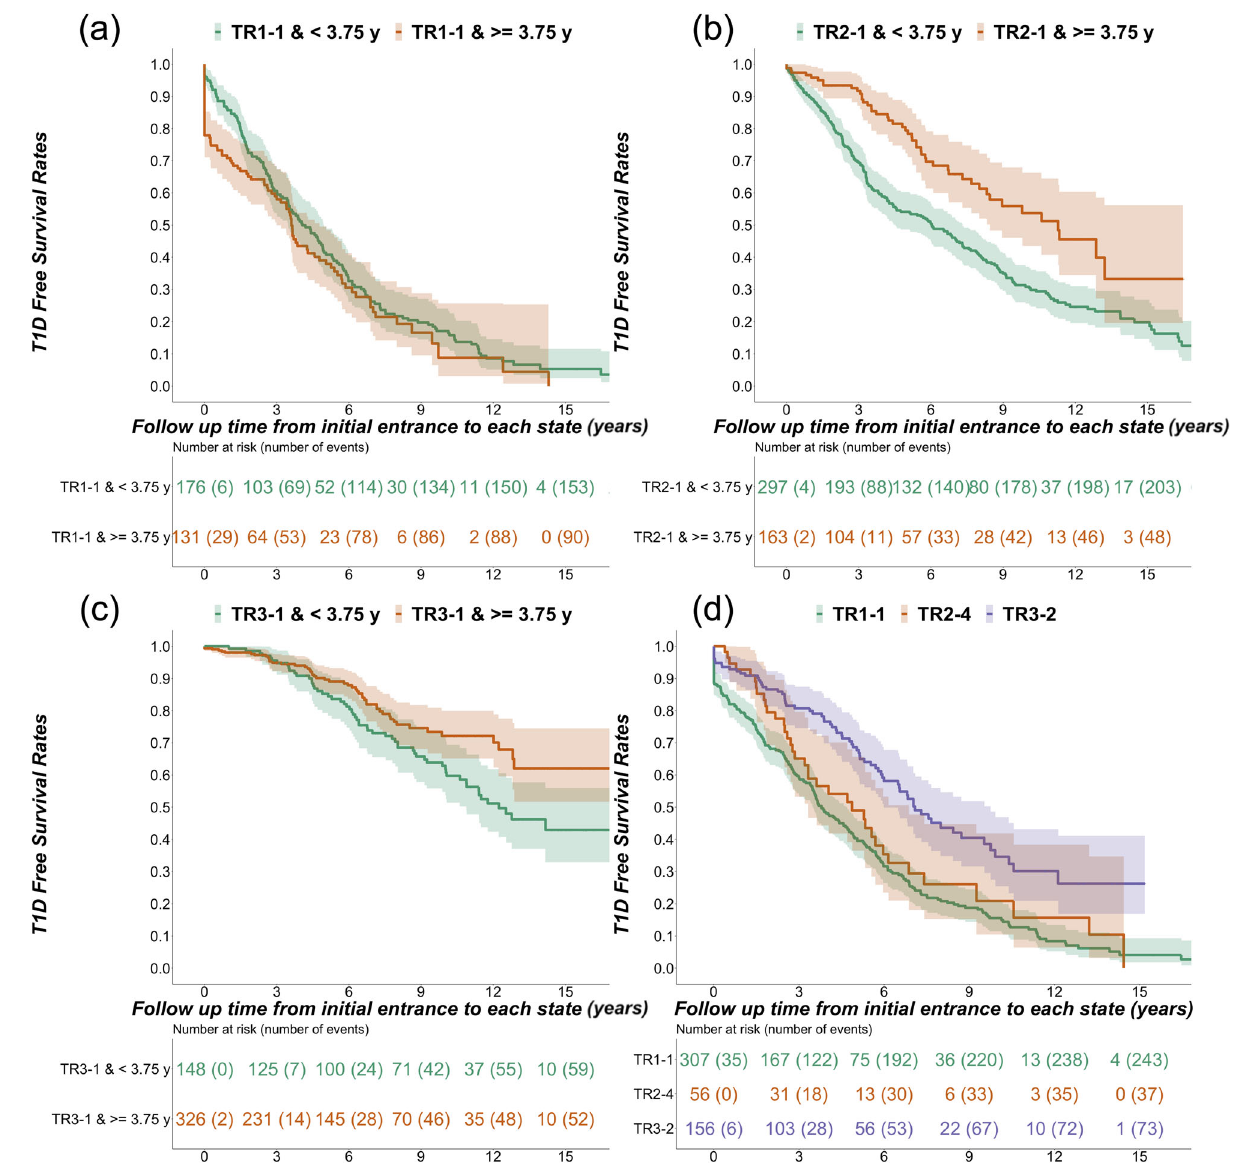
Fig. 5 Diabetes-free survival strati fi ed by age and trajectory state. T1D-free survival curves (mean and 95% con fi dence interval) of participants before or after median age, 3.75 years old, of entry into fi rst IAb positive state ( a TR1-1, b TR2-1, and c TR3-1). d T1D-free survival curves for individuals in GADA and IA-2 positive states (TR1-1, green; TR2-4, orange; TR3-2, purple). The median ages of entrance for GADA and IA-2A positive states were (i) TR1-1: 3.0; (ii) TR2-4: 7.6; (iii) TR3-2: 7.1 years old. Source data are provided as a Source Data fi age 25 years based on high-risk HLA genotype or history of fi rst-degree relative with type 1 diabetes. Presence or absence of three islet autoantibodies, GADA, IAA, and IA-2A, were combined across studies, and data were included up to a follow up (DPM) on presence or absence of IAb and the age of participants. The DPMs of 15 years or until the diagnosis of type 1 diabetes, whichever came fi rst, per discovered latent states from longitudinal measurements of the three IAbs from originating study protocols. Type 1 diabetes was diagnosed according to American each participant ’ s visit and the age of the participant at the visit (Supplementary Diabetes Association criteria 25 , seroconversion by two consecutive visits with at Table 3 and Supplementary Fig. 6 for examples of the observational data) 28 . Fur- least one IAb persistently positive at both visits and seroconversion age as the fi rst of the two visits. In addition to IAb measurements and outcome of diagnosis, the T1DI cohort contains anthropometric, metabolic, diet, and environmental mea- surements. All uses of human materials from the individual studies - BABYDIAB, DAISY, DEW-IT, DiPiS, and DIPP were each approved by their relevant ethics review boards: (i) BABYDIAB by the Bavarian ethical committee (Bayerische Landesärztekammer; No. 95357); (ii) DAISY by the Colorado Multiple Institutional Review Board (COMIRB; COMIRB 92-080); (iii) DEW-IT by WIRB-Copernicus Group Institutional Review Board (WCG-IRB; DSHS Project B-092199-H); (iv) DiPiS by the regional ethics board in Lund Sweden (Dnr LU-490-99); Joint Municipal Authority of Northern Ostrobothnia Hospital District, Regional Ethics Committee, Finland. All data and samples were collected under the written informed consent of the participants or their legal parents or guardians. number of latent states ranging from 2 to 20 were discovered from the time-